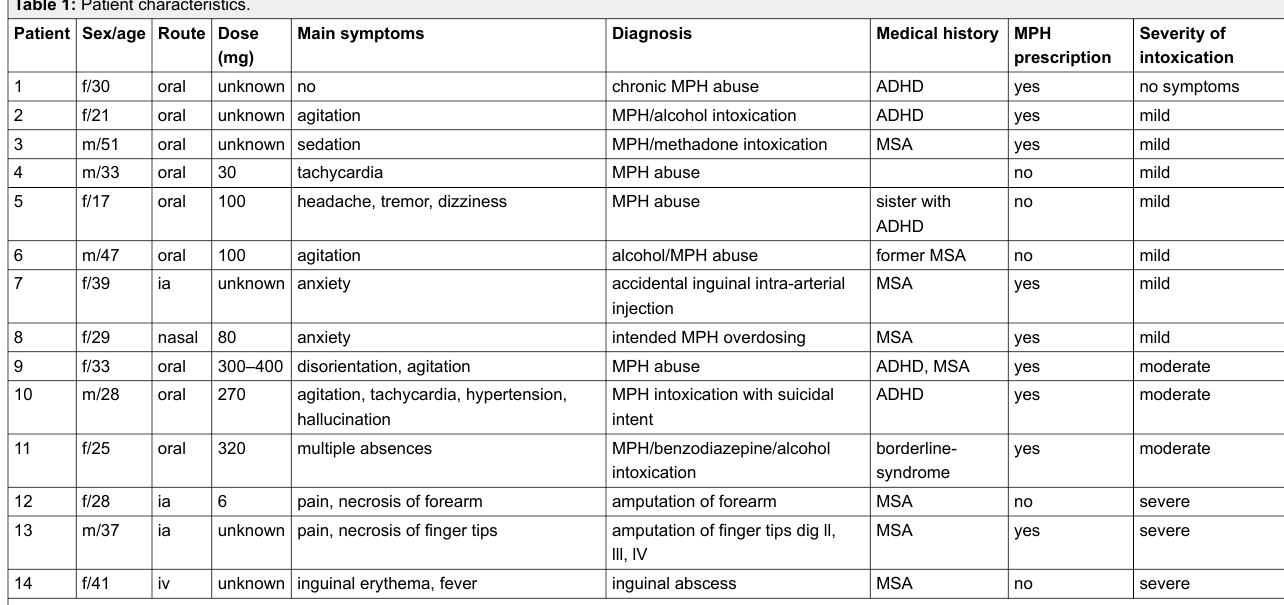
Table 1: Patient characteristics. Patient Sex/age Route Dose